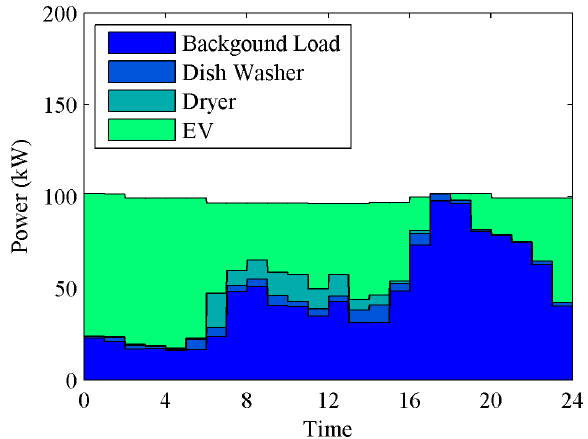
Figure 6. The PAPR and the normalized standard deviation of the load profile with a different number of flexibly charged EVs at a 50% EV penetration level.